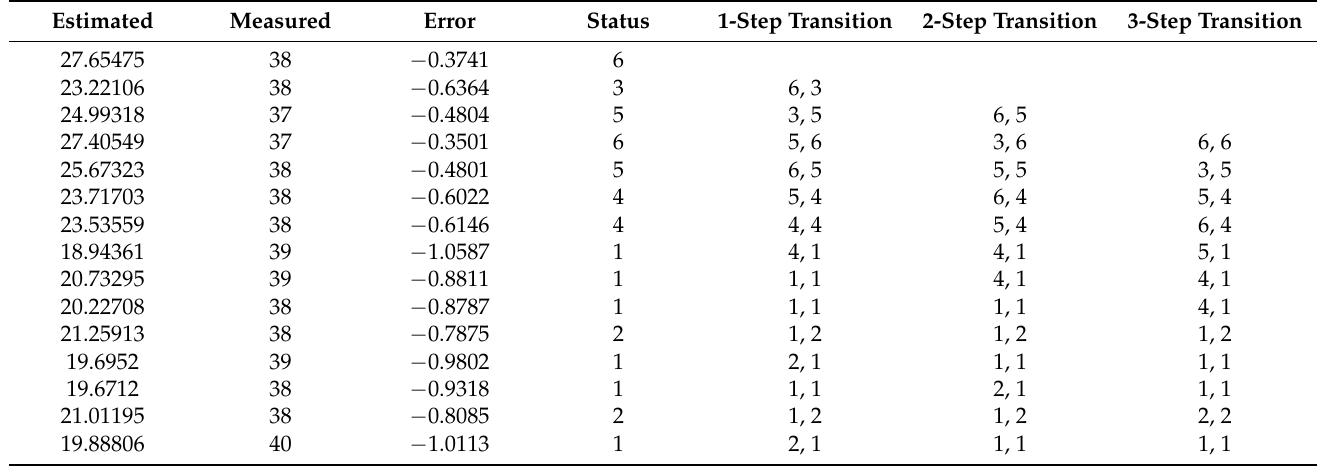
Table 5. The status transition of some of the data for PM2.5.